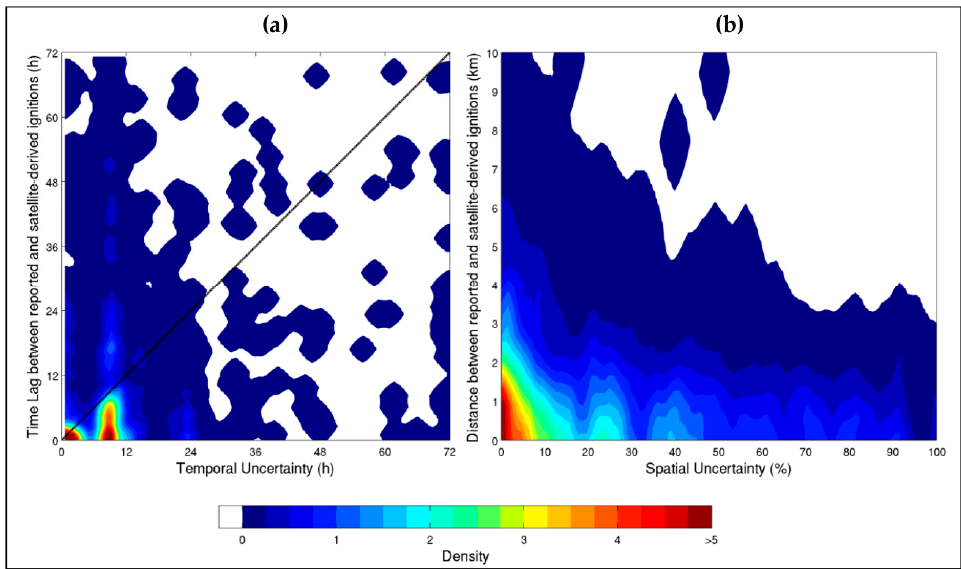
Figure 9. Comparison between ( a ) temporal discrepancy and temporal uncertainty of satellite-derived ignitions (hours); and ( b ) temporal discrepancy and spatial uncertainty of satellite-derived ignitions (hours) ( N = 1376). The colorbar indicates the number of pairs within each temporal uncertainty/reported-estimated time lag bin ( a ) and spatial uncertainty/reported-estimated distance bin.